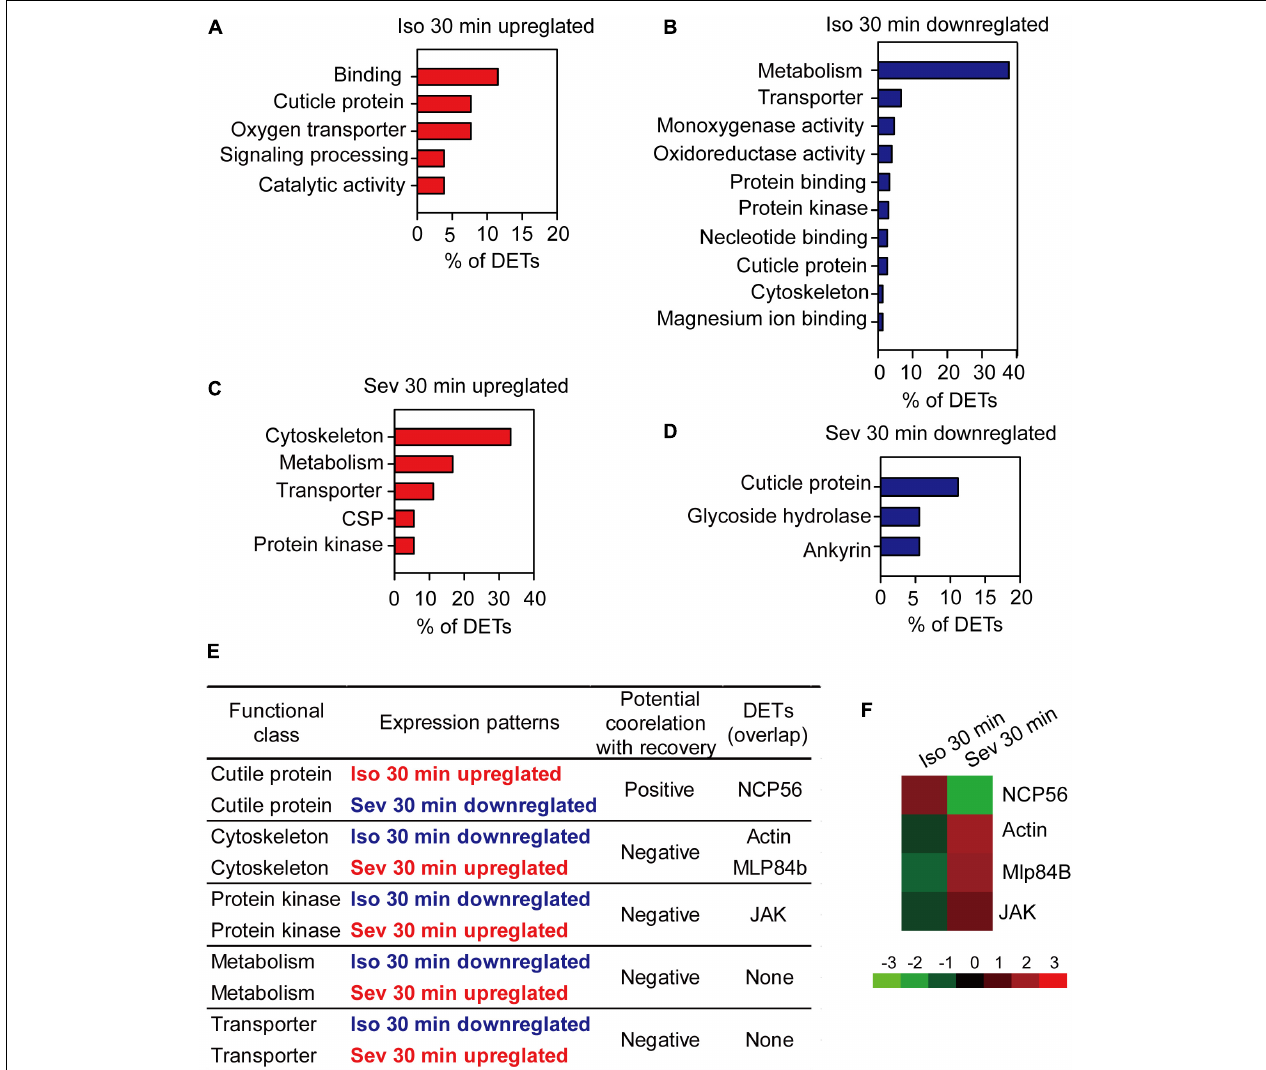
FIGURE 4 | The pivotal genes potentially involved in post-anesthesia recovery in brains of the migratory locusts. (A,B) Functional classes of upregulated (A) and downregulated (B) DETs induced by 30 min of isoflurane exposure. (C,D) Functional classes of upregulated (C) and downregulated (D) DETs induced by 30 min of sevoflurane exposure. (E) The functional classes potentially correlated with post-anesthesia recovery from isoflurane and sevoflurane. (F) Expression levels of the four pivotal transcripts potentially involved differential recovery from isoflurane and sevoflurane anesthesia. Mlp84B, Myosin-like protein 84B; NCP56, nymph cuticle protein 56; JAK, Janus kinase; Iso, isoflurane; Sev, sevoflurane.